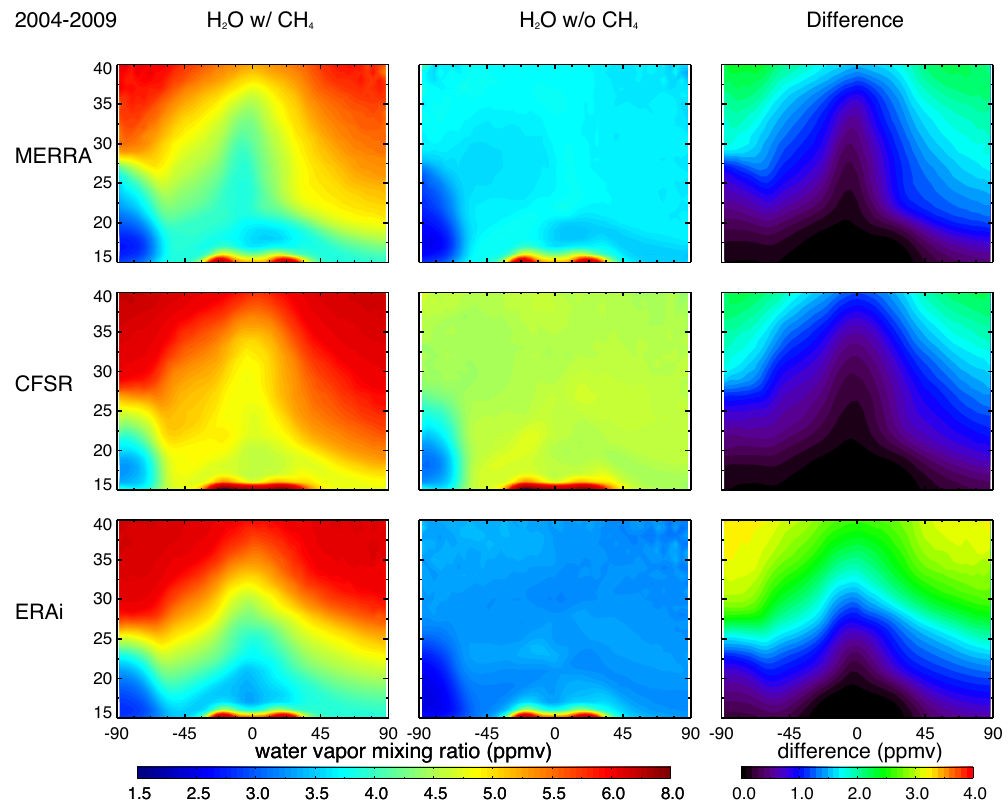
Fig. 6. Comparison of time mean (2004–2009) water vapor. Left column, full simulation including methane oxidation; middle column, without methane oxidation; right column shows difference. These integrations do not include gravity wave parameterization, convective adjustment, and saturation is set to